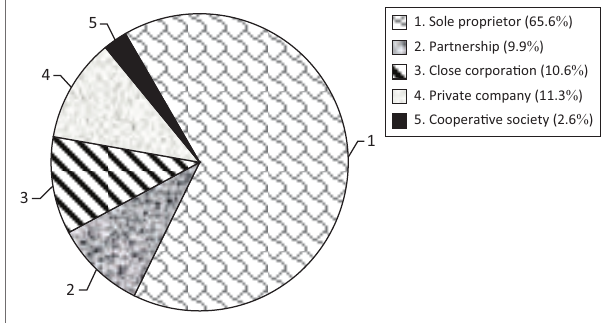
FIGURE 7: Form of business ownership.